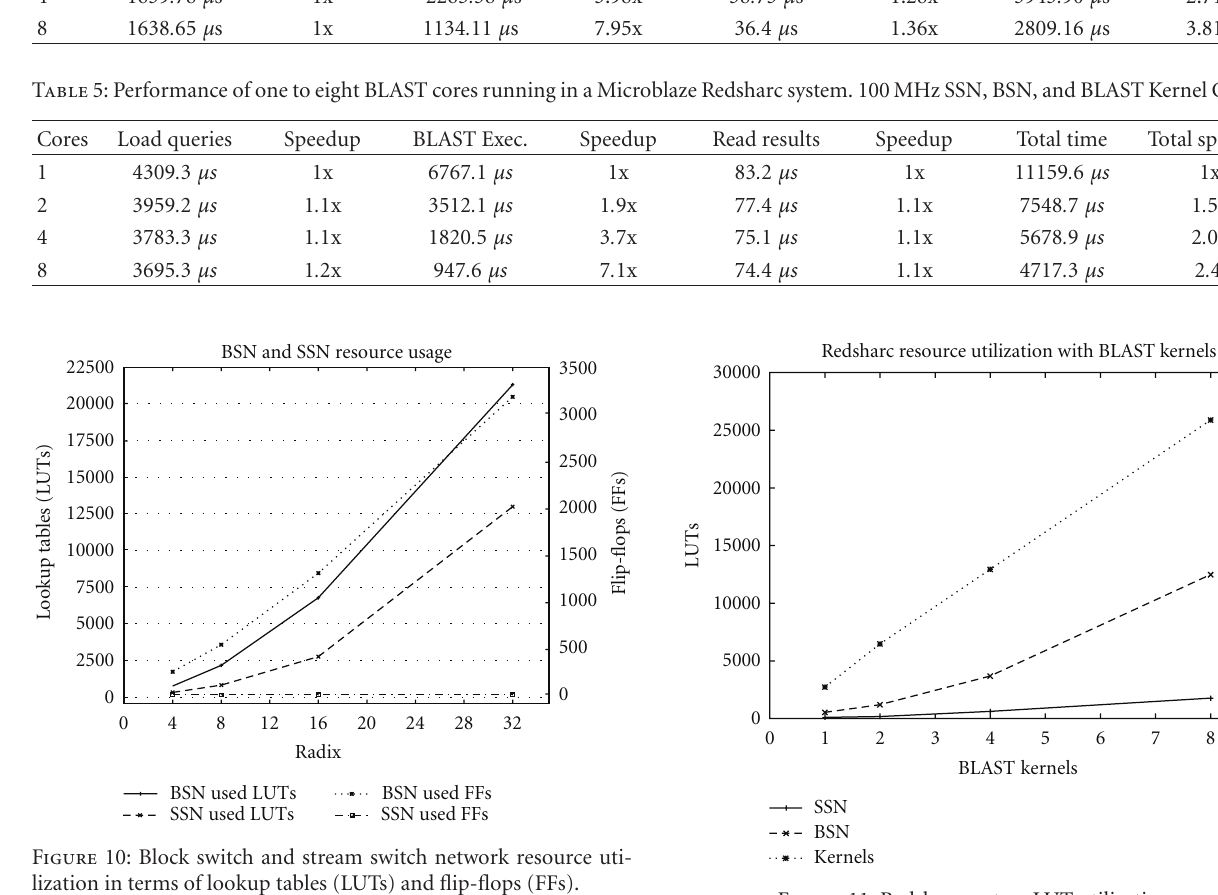
Figure 11: Redsharc system LUT utilization. Table 7: BSN and SSN LUT and FF resource